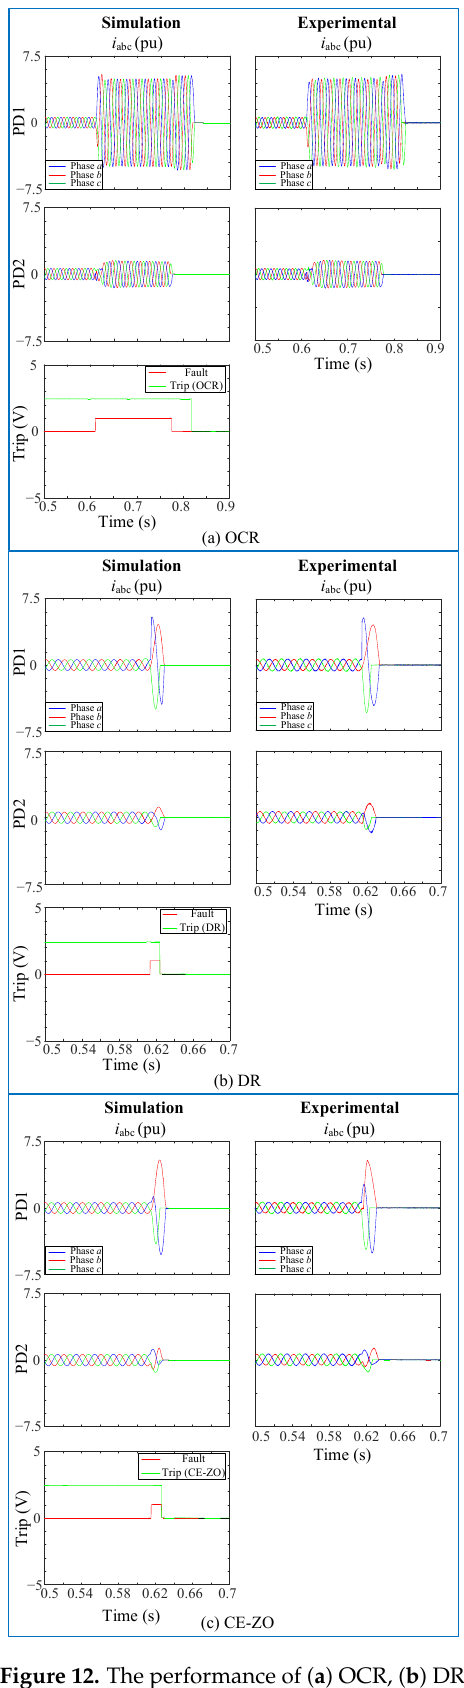
Figure 12. The performance of ( a ) OCR, ( b ) DR, and ( c ) CE-ZO during a three-phase fault at F1.